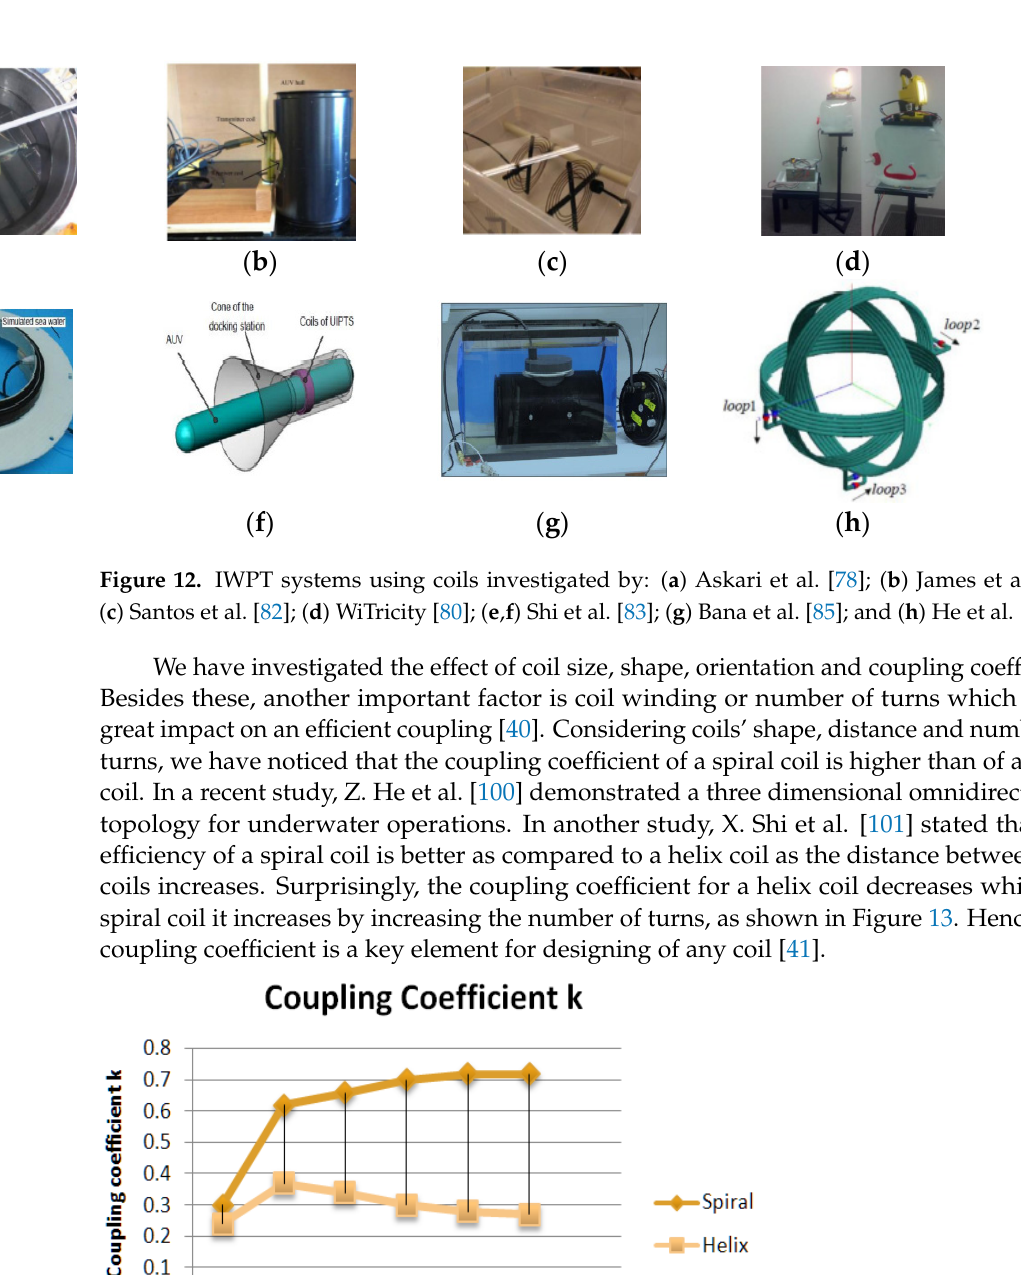
Table 5. Comparison between different coupling mechanisms.